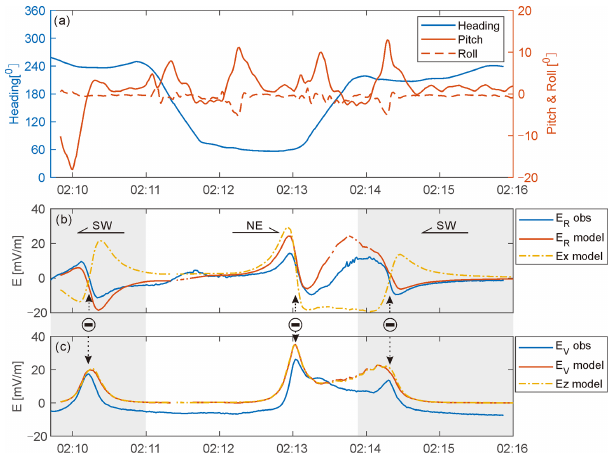
Figure 6. Comparison of the measured data and numerical simula- tion: (a) navigation attitude of the AUV in the water; (b) time se- ries of modeled and observed horizontal components with different travel directions; and (c) modeling and observed vertical compo- nent for SW, NE, and SW profiles. Minus signs correspond to the location of negative pole of the artificial